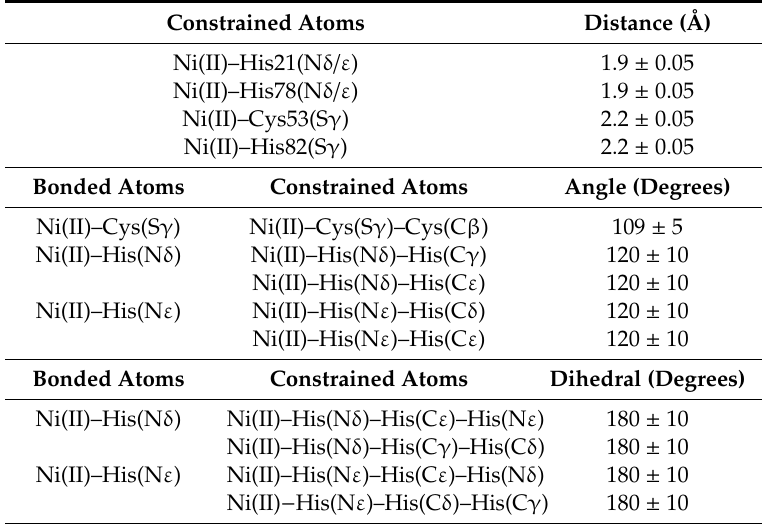
Table 2. Distances, angles, and dihedral constraints used in the modelling of Ni(II)-bound Sy InrS. All constraints in the form mean ± 1 standard